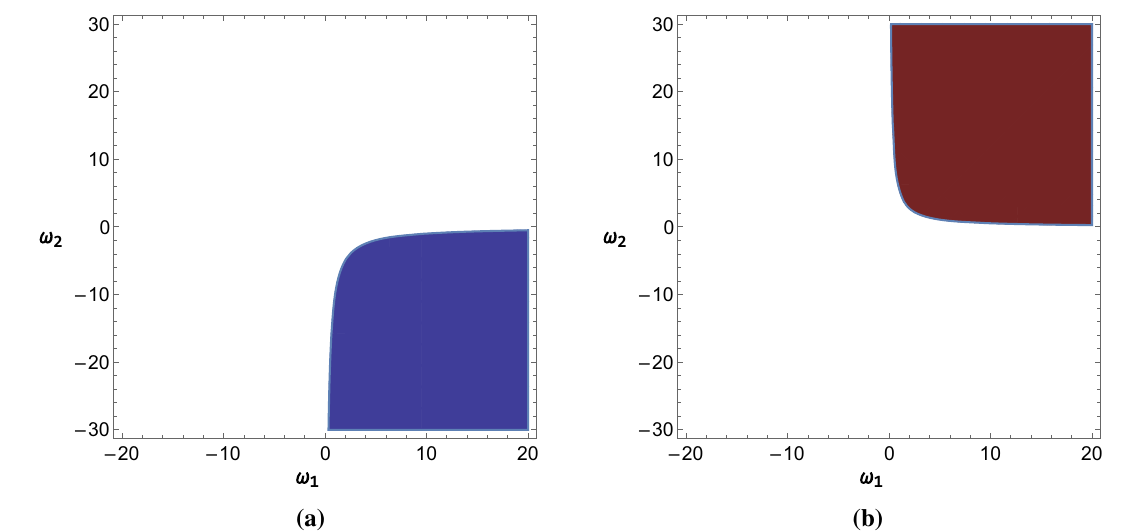
Fig. 3 a The case where the critical point B − − has a stable cosmological behavior, considering w m = − 0 . 001, α = 2 (left panel), b the situation where B + + corresponds to a stable scenario, considering w m = − 0 . 01, α = − 1 (right